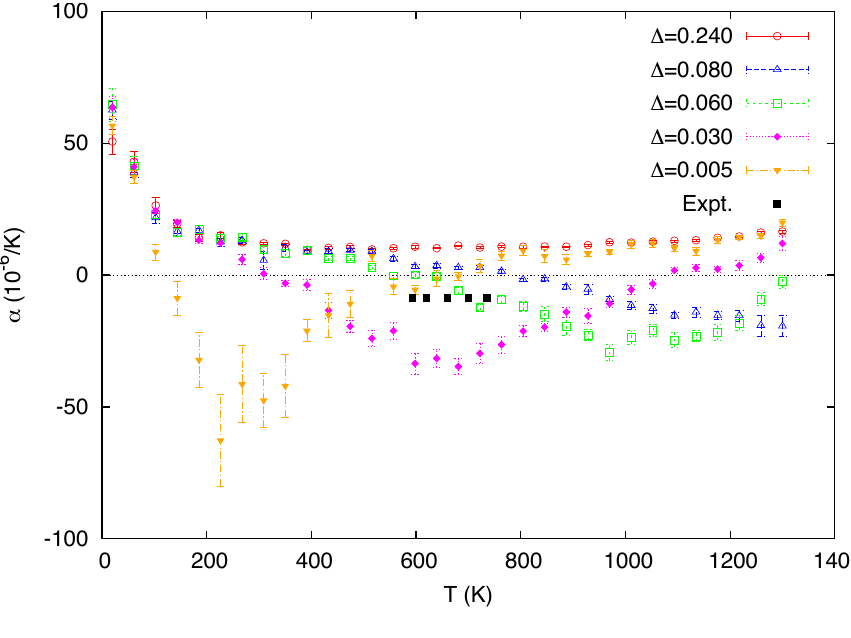
Figure 4. Calculated temperature dependence of the linear coefficient of thermal expansion for a varying value of the mixing energy ∆ (in eV). The experimental data [48] in the stability range of δ -Pu are also included for comparison.